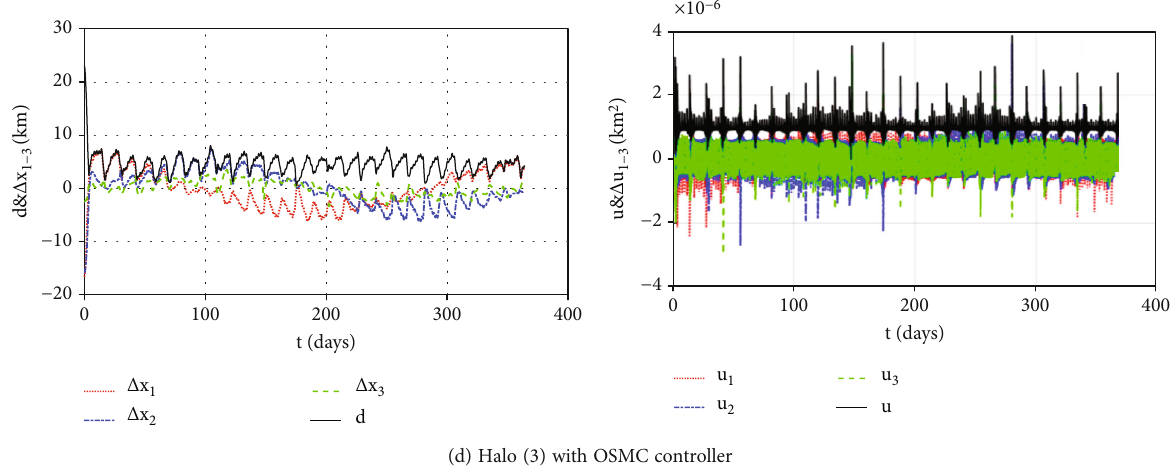
Figure 13: The station-keeping simulations under practical constraints with the SRP as the perturbation. Table 7: The performance indexes of the station-keeping simulations with practical constraints and di ff erent perturbations.